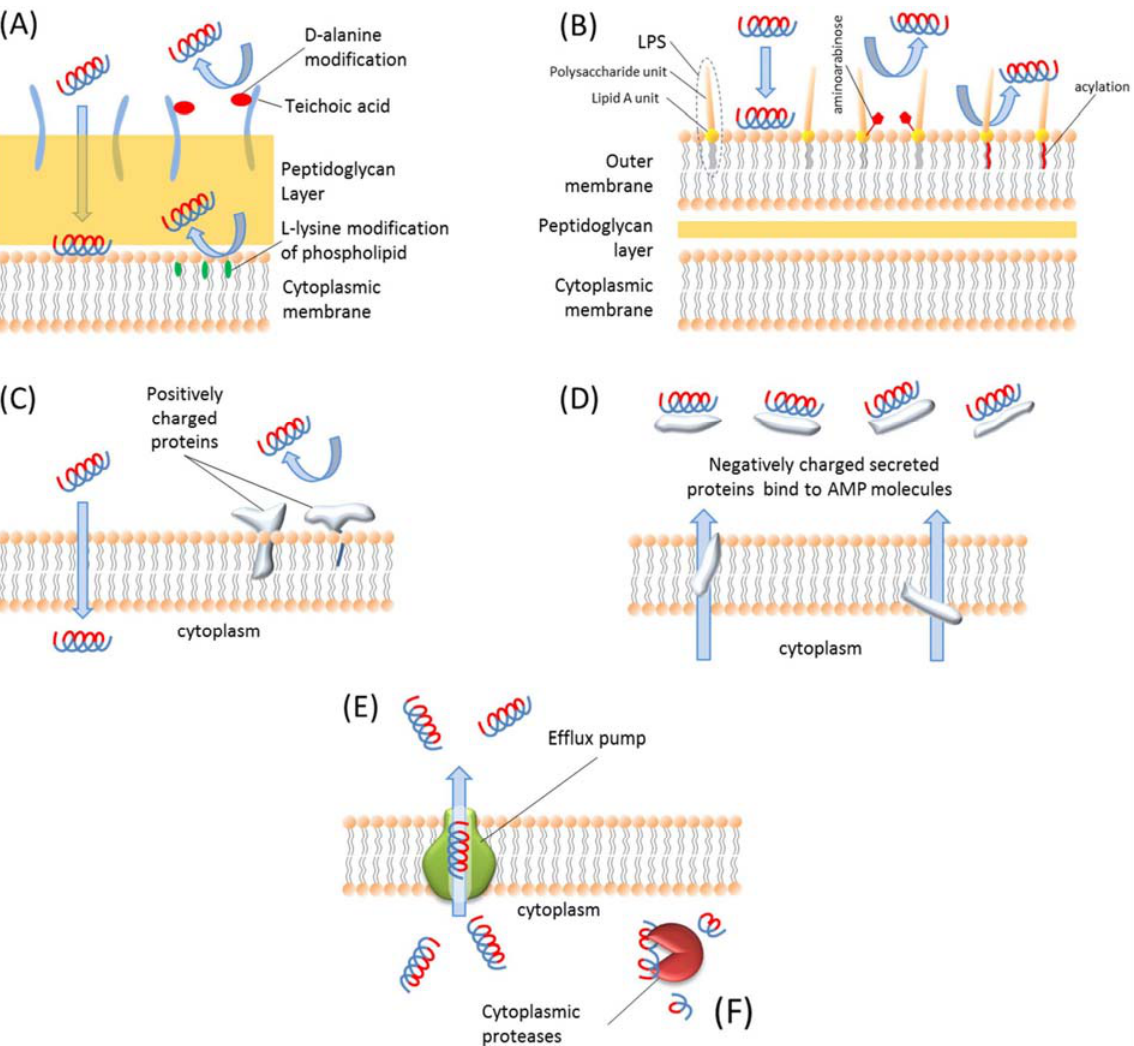
Figure 3. Schematic representation of AMP resistance mechanisms. ( A ) Gram-positive bacteria resist AMPs via teichoic acid modification of LPS molecules and L -lysine modification of phospholipids. ( B ) Gram-negative bacteria resist AMPs by modifying LPS molecules with aminoarabinose or acylation of Lipid A unit of LPS molecules. ( C ) Bacteria express some positively charged proteins and integrate them in the membrane so positive charges repulse each other and bacteria can resist such AMPs. ( D ) Bacteria produce negatively charged proteins and secrete them into extracellular environment to bind and block AMPs. ( E ) The intracellular AMPs are extruded by efflux pumps. ( F ) The AMPs inside the cell are degraded by